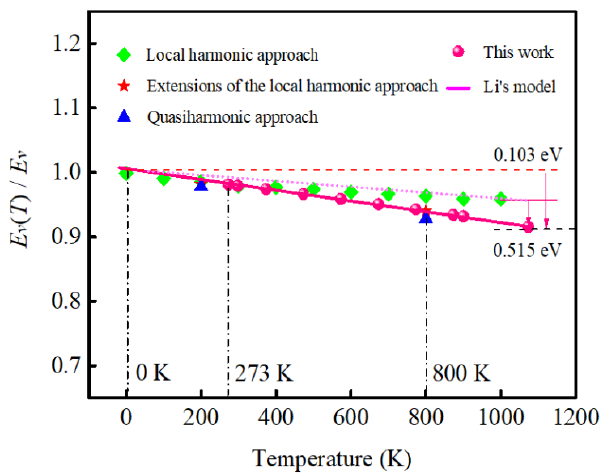
Figure 4. Temperature effect on the vacancy formation energy of AuNPs. (The detailed calculation parameters: Um (b,0) is the internal energy at 0 K, Cp is the specific heat capacity at constant pressure, and the relevant data can be found in the supplementary materials Tables S10,S11.)